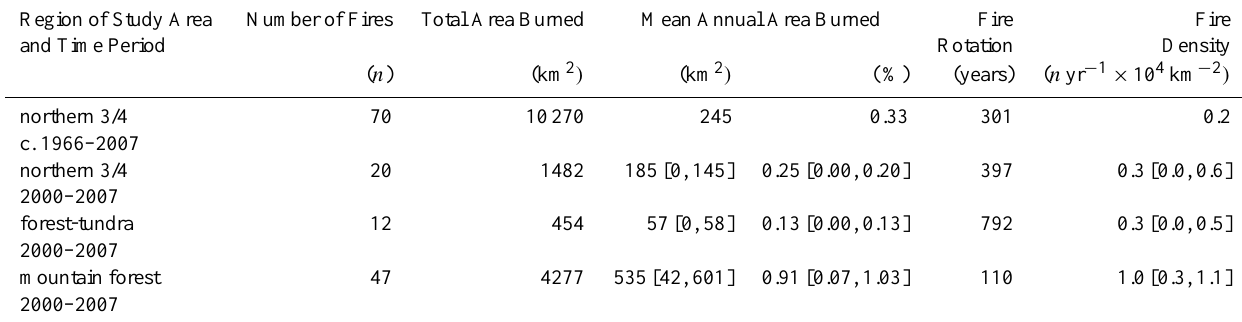
by piecewise linear regression. In comparison to a simple linear regression, using a two-segment regression with a breakpoint set between 26–34 yr reduced the residual vari- ance when modelling median fire-level AGB as a function of time (148 × 10 5 vs. 162 × 10 5 ) . During early